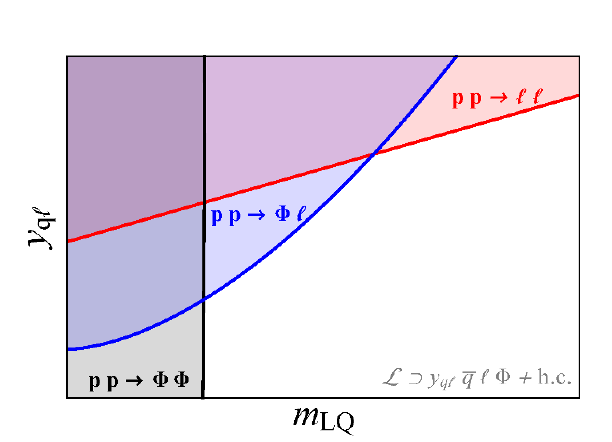
Figure 5 . Complementarity illustration for the three LQ processes at the LHC on the ( m LQ ; y q‘ ) parameter space. LQ pair production, dominated by QCD, is (largely) insensitive on the coupling y q‘ , setting therefore a robust lower limit on the LQ mass m LQ . At the opposite end of the LQ mass spectrum, the strongest bound comes from the Drell-Yan production of a dilepton pair via a t (cid:0) channel LQ exchange since amplitude scales with y 2 . Finally, in the intermediate mass range, q‘ production of a single LQ in association with a lepton is expected to be the most sensitive probe as the associated amplitude scales linearly with y q‘